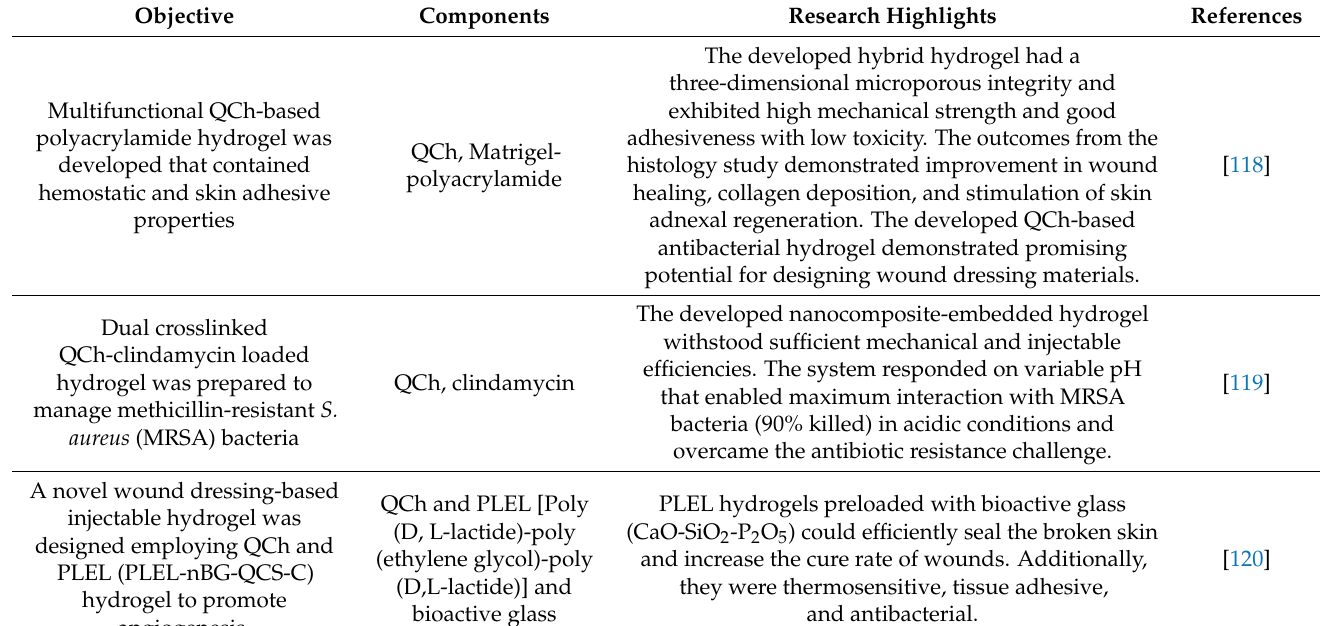
Table 4. Biomedical utility of QCh-derived